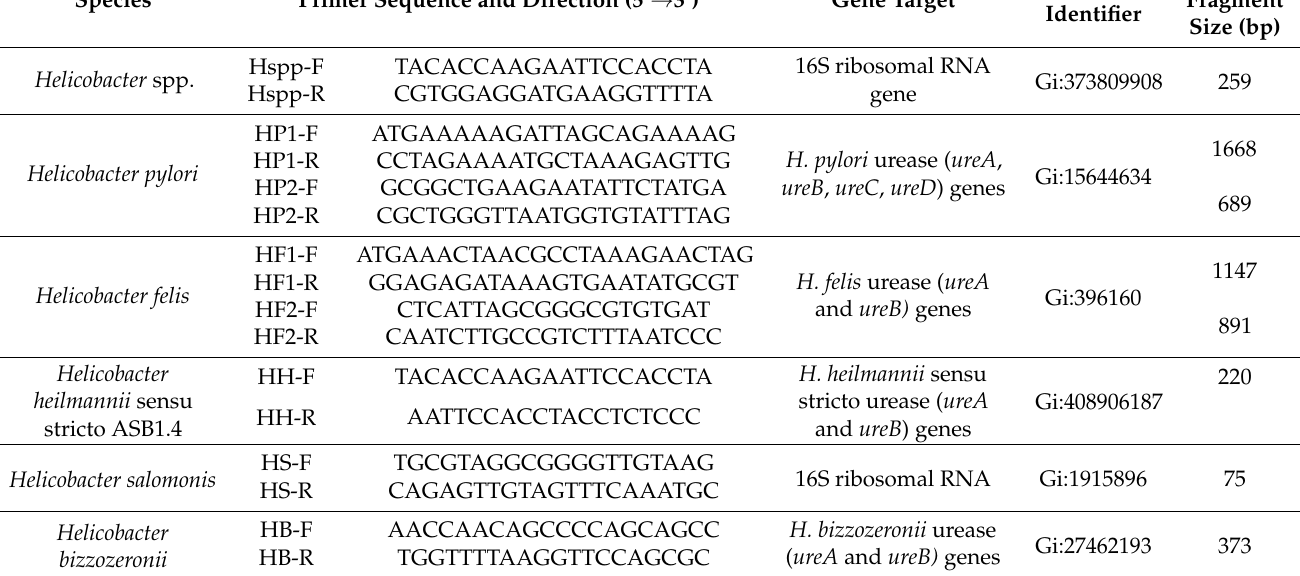
Table 1. Primer sequences for Helicobacter genus and species-specific PCR amplification used in the study of 84 dogs with chronic gastrointestinal